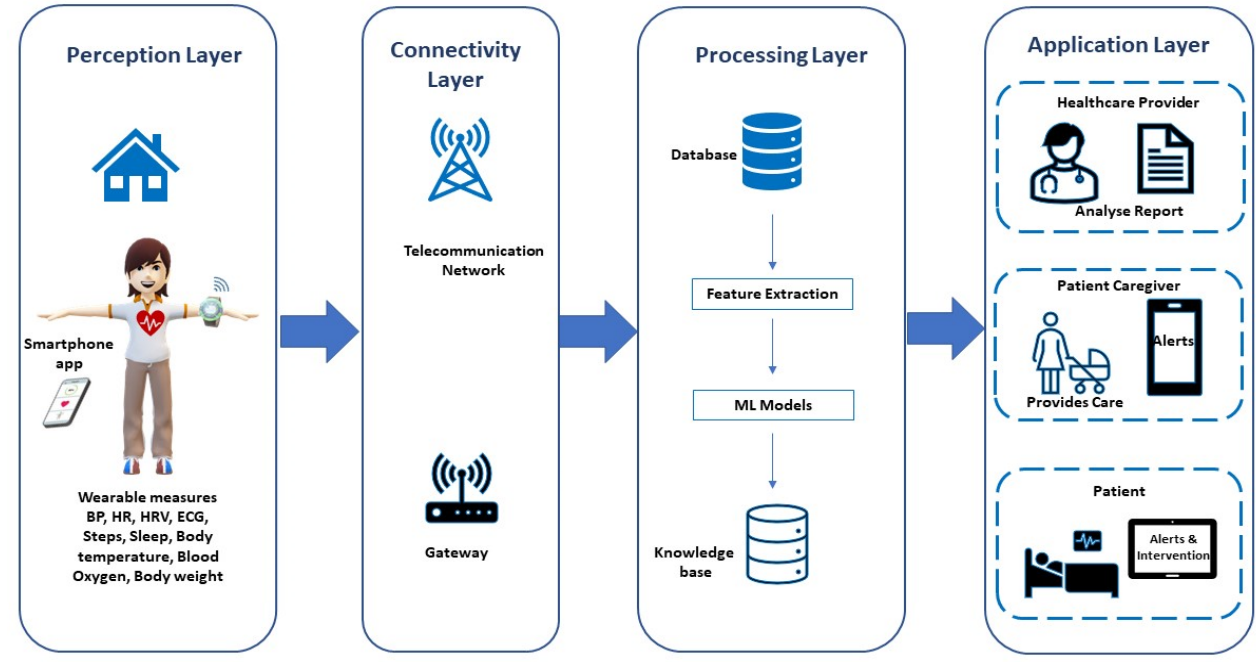
Figure 3. An IoT-based SHT for CVD monitoring. (The layers have specific functionalities. Perception layer: Consist of all sensors in an SHT setting to capture vital recordings, such as blood pressure, heart rate, heart rate variability, electrocardiogram, blood oxygen and other signals, such as sleep, step count, body temperature and weight. Connectivity layer: Transfer the sensor data from the internal network to the processing layer over an external network. Processing layer: Stores the data and performs the specified analysis. Application layer: Displays the processed data to healthcare providers, who initiate necessary intervention through caregivers or patients.)